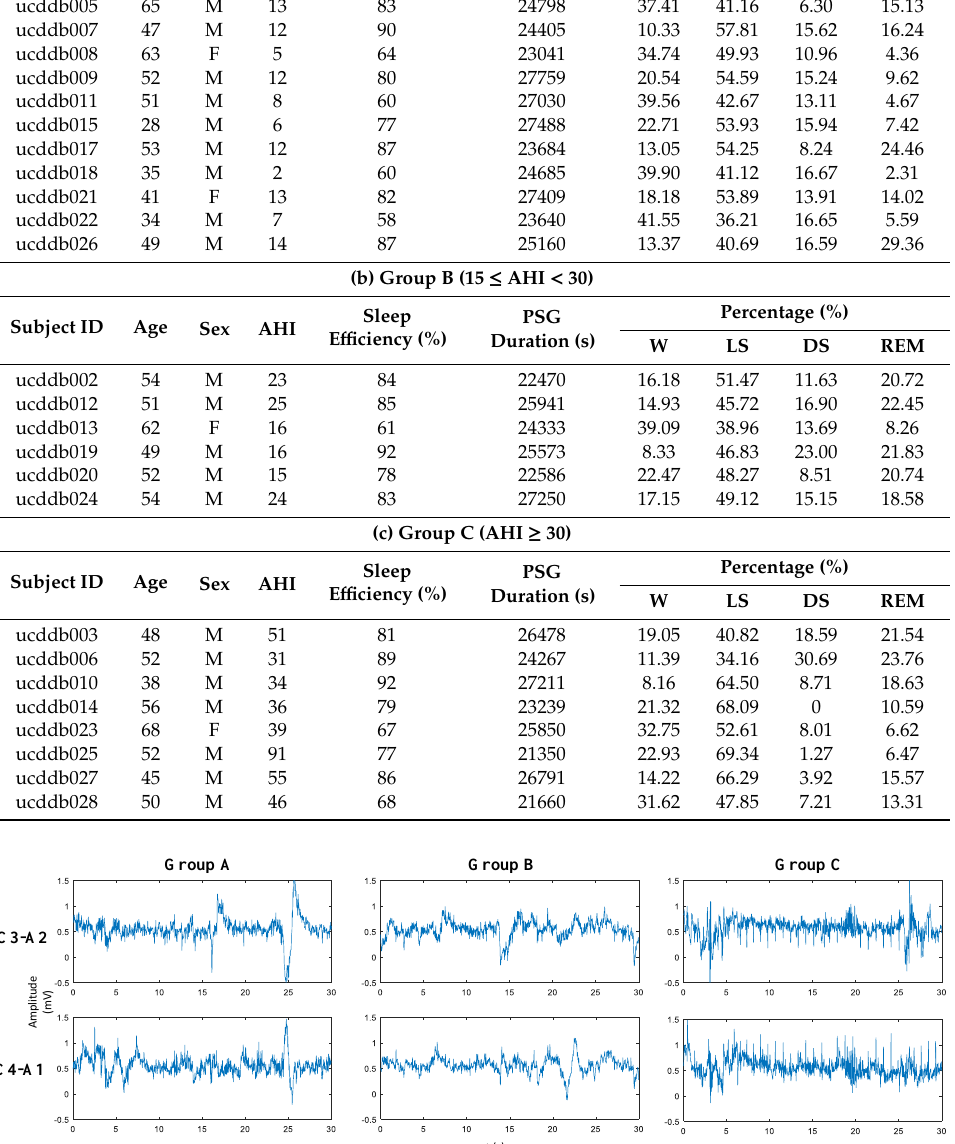
Figure 1. Illustration of 30 s epoch C3-A2 and C4-A1 EEG signals for Group A, B, and C.